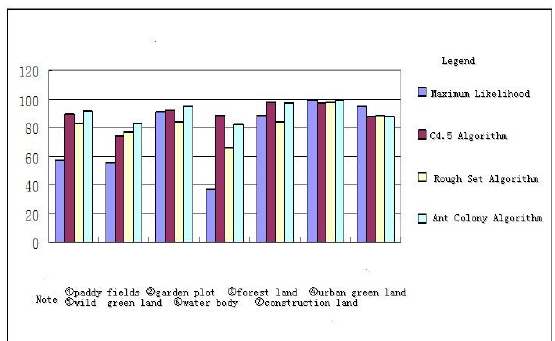
Figure8. Comparison of producer's accuracy based four classification methods